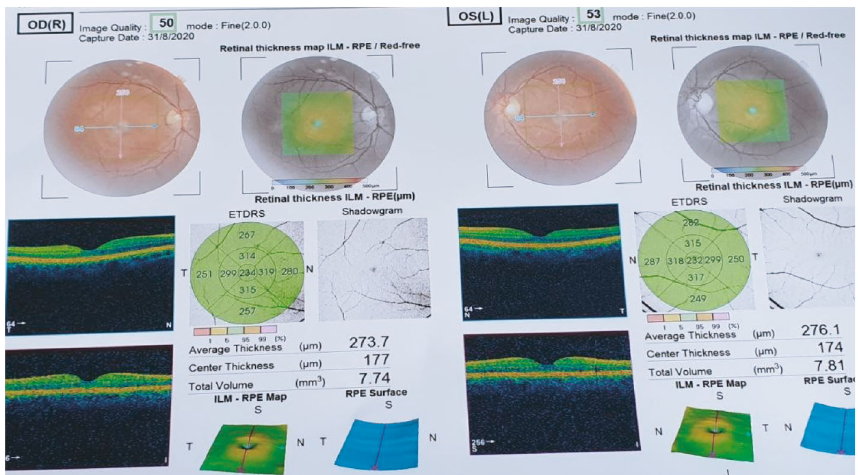
Figure 2: Macular OCT and color photograph showing normal fi